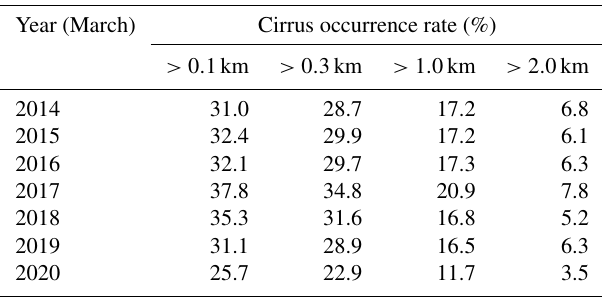
Table 2. The occurrence rates of cirrus clouds with the definition based on different geometrical cloud thicknesses larger than 0.1, 0.2, 1.0, and 2.0km, respectively, in March of the years 2014–2020. Cirrus occurrence rate (%) > 0 . 1km > 0 . 3km > 1 . 0km > 2 .